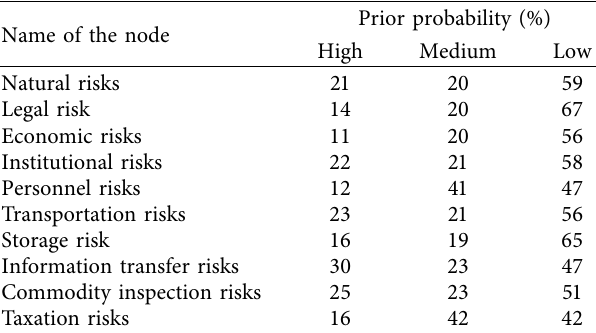
Table 3: Value assignment to intermediate